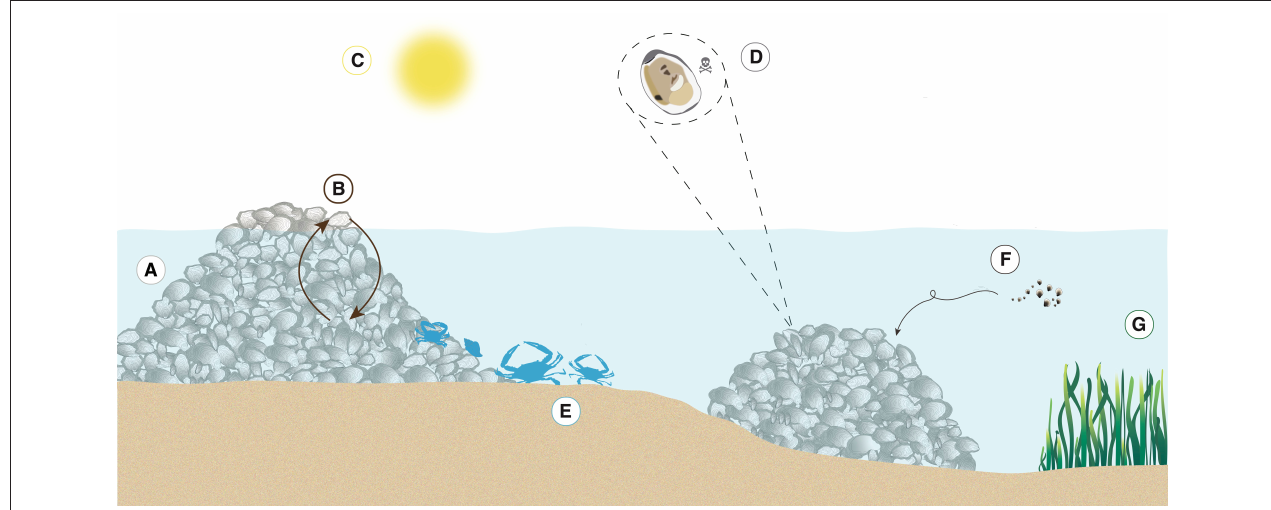
FIGURE 2 | Schematic depiction of the seven categories of positive interactions on oyster reefs: (A) physical reef creation, (B) positive density dependence, (C) refugia from abiotic stress, (D) refugia from biotic stress, (E) biodiversity enhancement, (F) settlement improvement, and (G) long-distance facilitation.